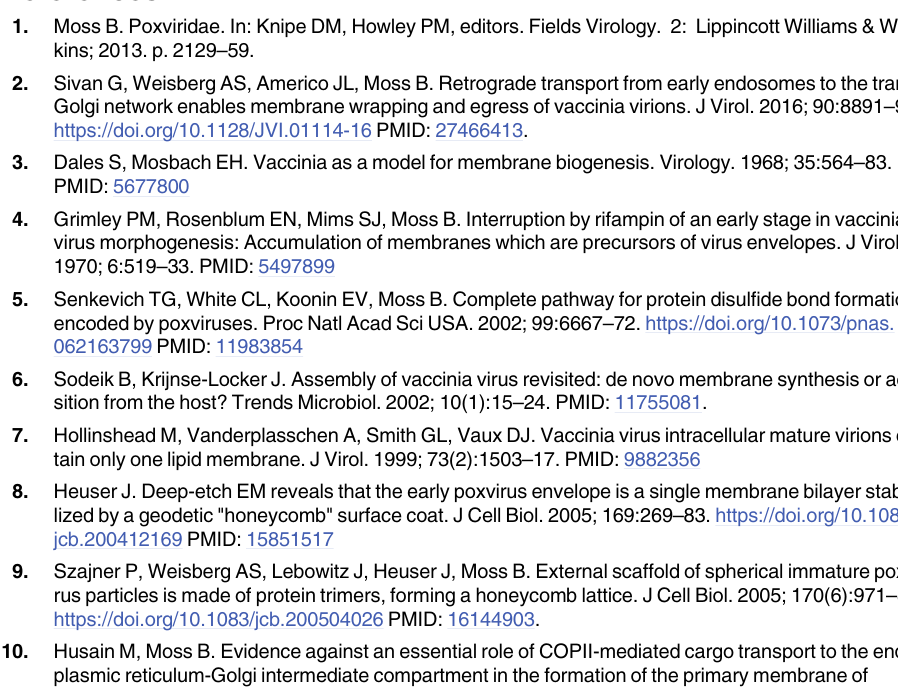
Fig 2. Model for poxviral membrane biogenesis. The first step (1) consists of modification of the ER by insertion of the A17 transmembrane protein represented by pink boxes. In the presence of all 5 VMAPs represented by blue spheres, membrane scission occurs, and the edges of the sheets are stabilized (2). D13 trimers, represented by green triangles, associate with the N-terminus of A17 to increase curvature forming crescent structures (3), which extend by fusion with additional membrane segments around core proteins (violet) to form the spherical IVs (4). VMAPs missing at least one component ( Δ VMAP) represented by blue sickle shapes are unable to induce or stabilize membrane scissions (2’), the crescents remain attached to the ER (3’), and empty IV-like particles bud into the lumen while the core proteins form dense aggregates (violet) outside of the ER (4’). Drawings kindly provided by A . Weisberg .